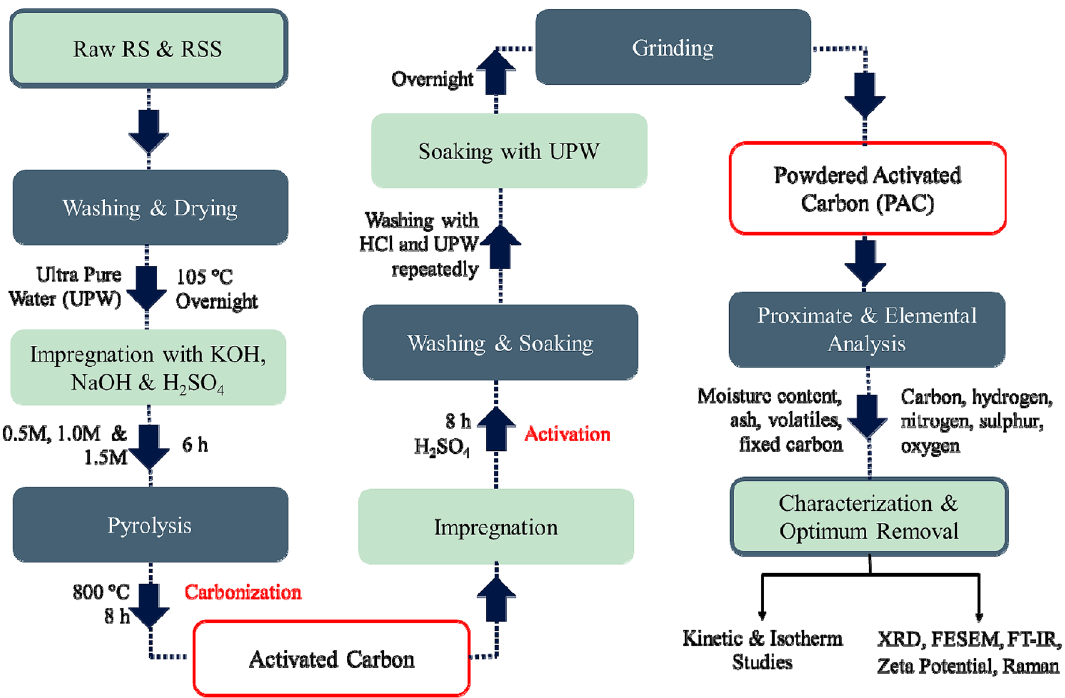
Figure 10. Process for fabrication and synthesis of PAC from RS and